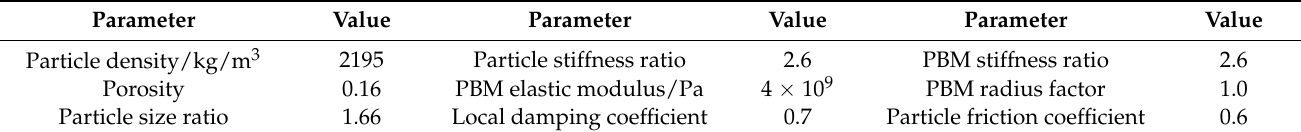
Table 1. Main micro-parameters of the model.